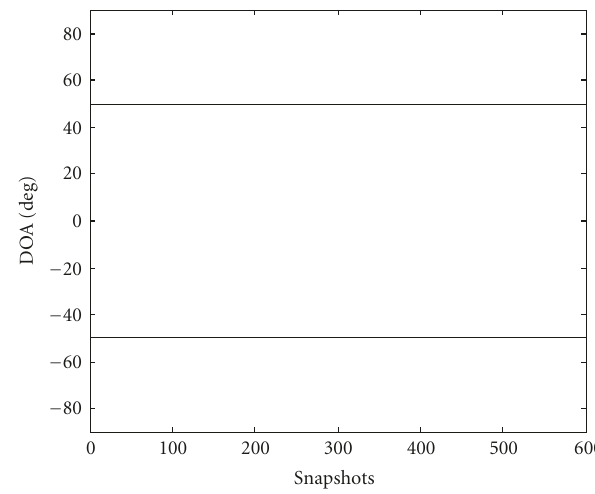
Figure 1: The trajectories of sources in the first simulation scenario.